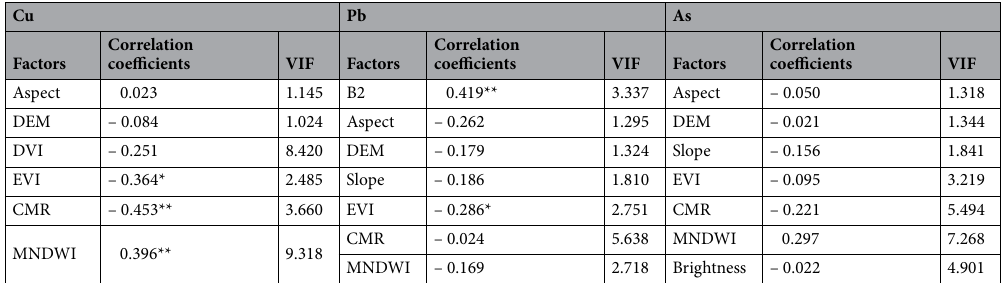
Table 4. Correlation and VIF values highlighting the optimal factors associated with the concentrations of Cu, Pb, and As in the soils. *represents the significance level at P < 0.05, **denotes the significance level at P < 0.01.